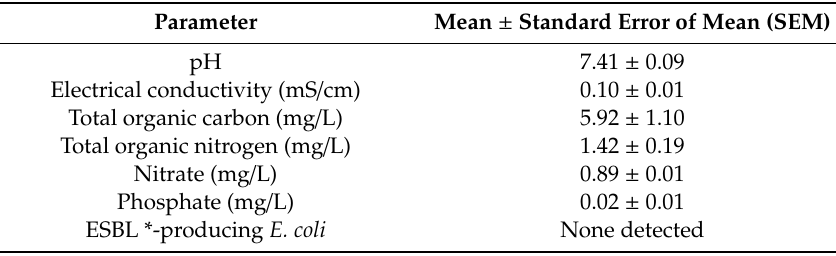
Table 1. Chemical and microbiological characteristics of the